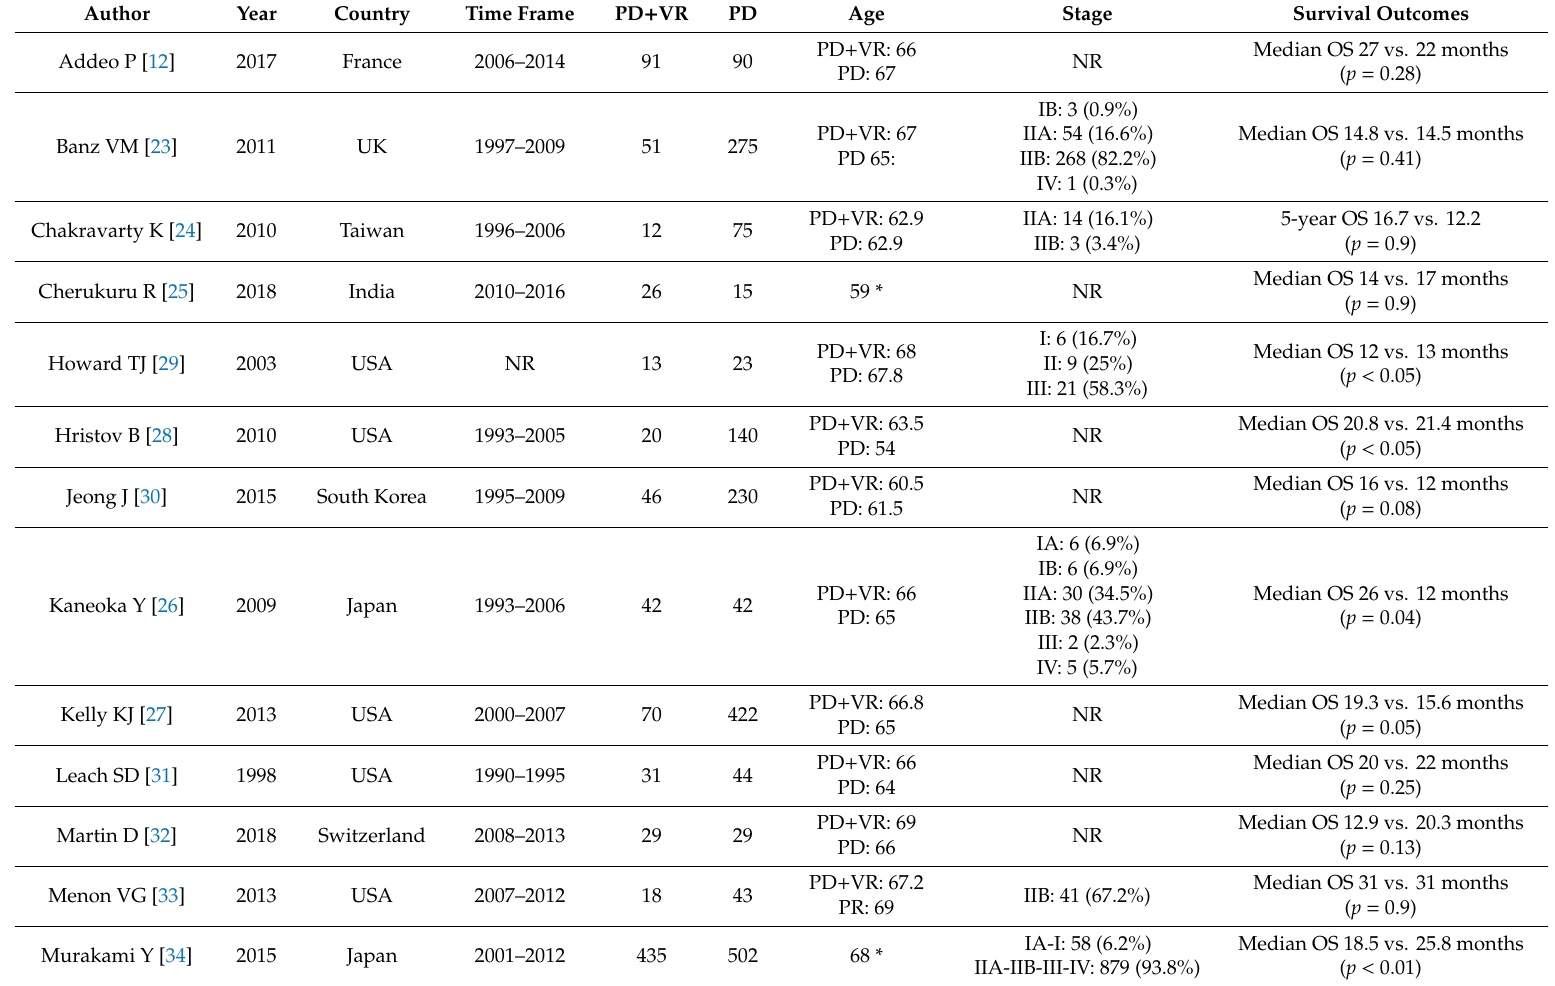
Table 1. Characteristics of the studies included in the